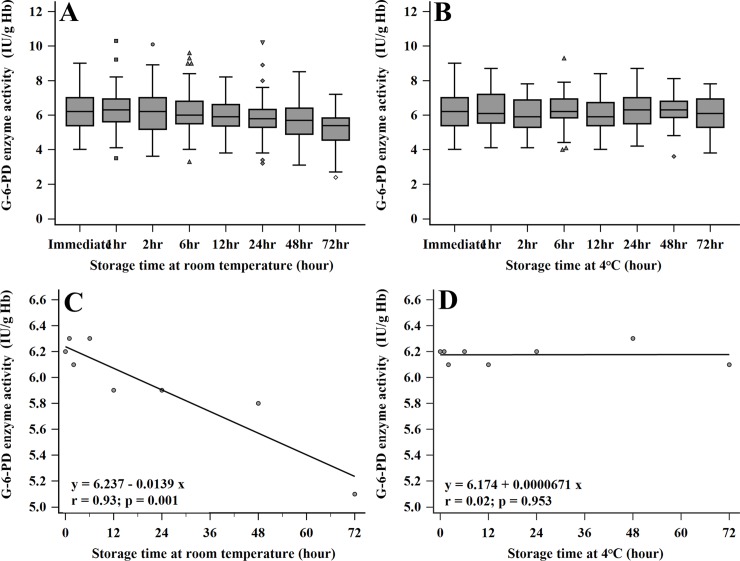
Variation of G-6-PD activity detection after storage for 72 hours at room temperature (A) and 4°C (B). The ●, ■, ▲, and ♦ symbols indicate outlier data with less or greater than the interquartile range (<5th or > 95th percentile). Regression analysis of G-6-PD activity detection after storage for 72 hours under room temperature (C) and 4°C (D).